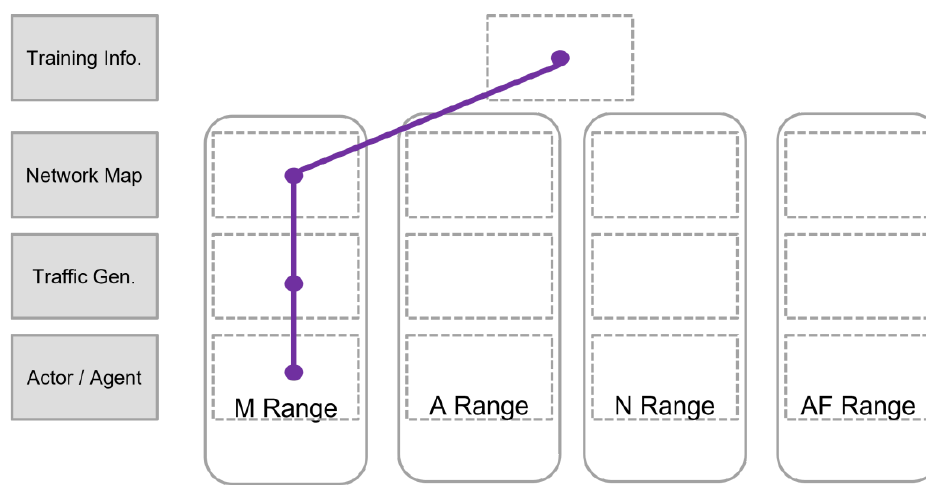
Figure 5. Scenario Authoring at Single Range.